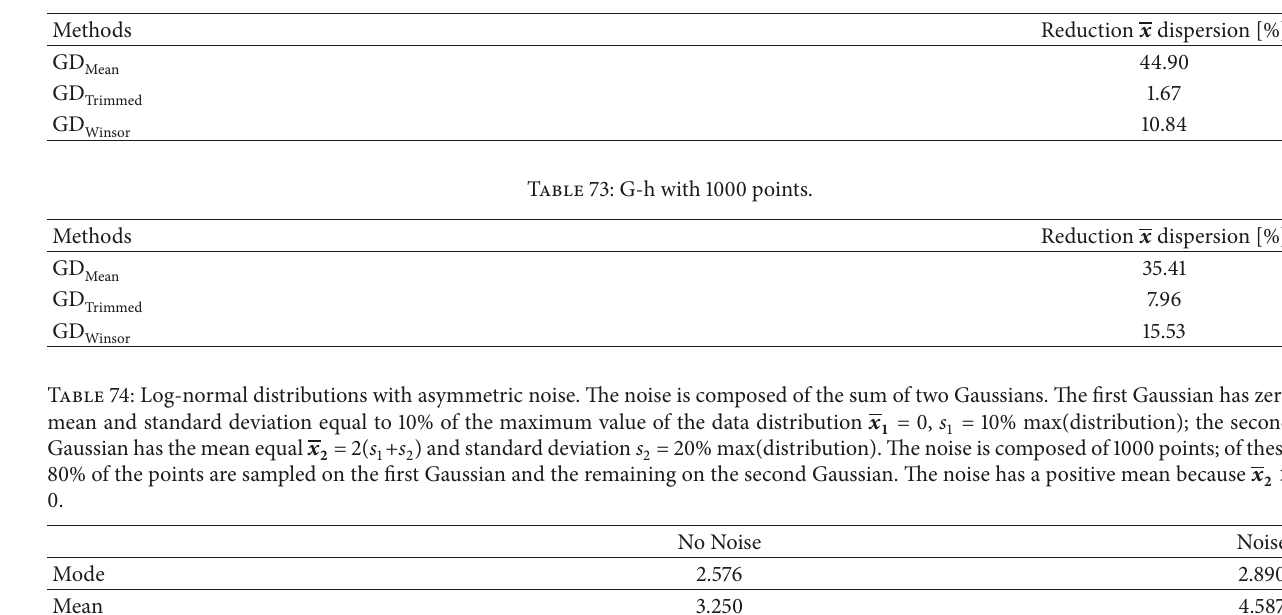
Table 72: G-h with 100 points.